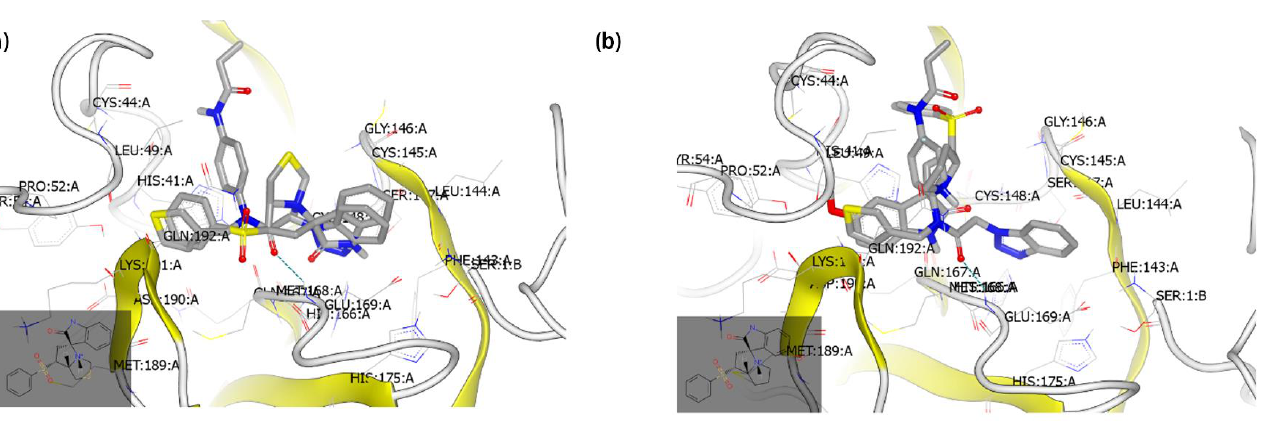
Figure 5. Visual representation for compounds docked against (PDBID: 4ylu) visualized by vida application: ( a ) compound 4i docked with the receptor through hydrophobic – hydrophobic interaction; ( b ) compound 4h docked in a different domain.